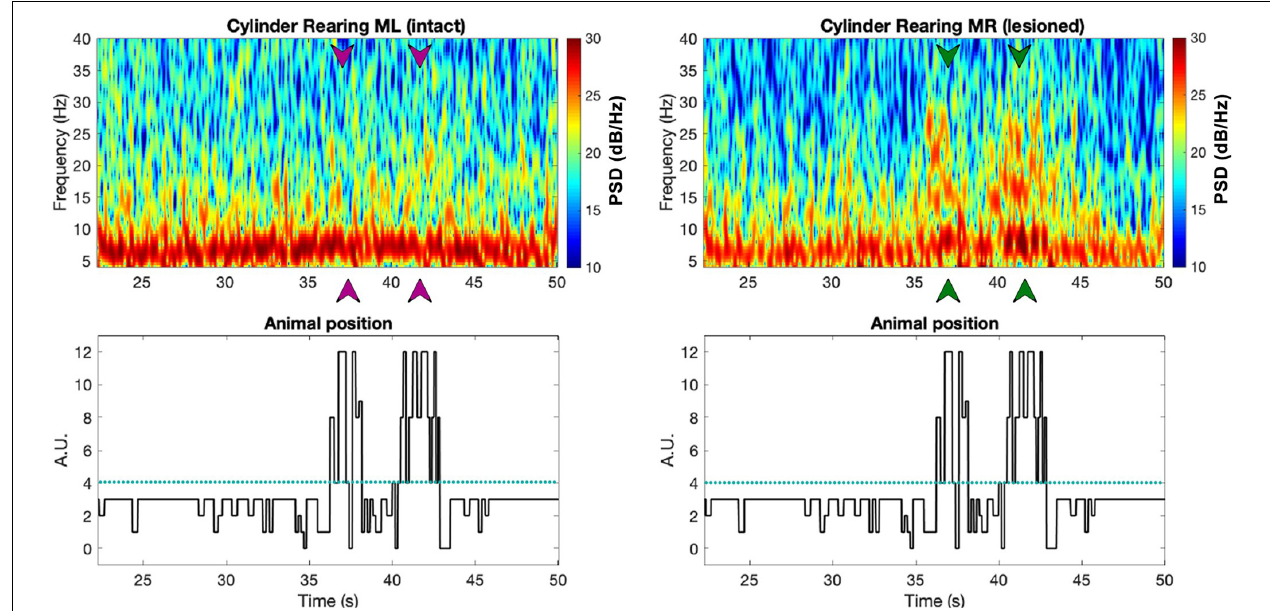
FIGURE 8 | The top two plots show spectrogram examples from the intact (left) vs. lesioned (right) hemispheres captured from bilateral M1 of a PD rat (R21), with the digitized behavioral pattern shown below each spectrogram. Note that the arrows in the spectrograms point at the times in which the animal was rearing, as can be seen from the forelimb position plot below (green and purple correspond to the lesioned and intact hemispheres, respectively). Figure adapted from Mottaghi